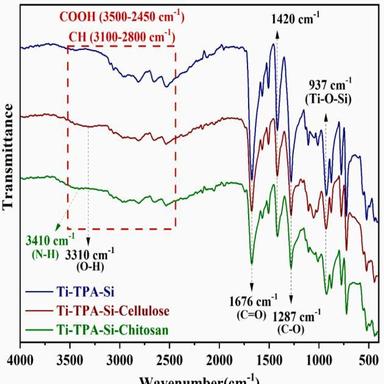
FTIR spectra of Ti-TPA-Si, Ti-TPA-Si-C, and Ti-TPA-Si-CS.